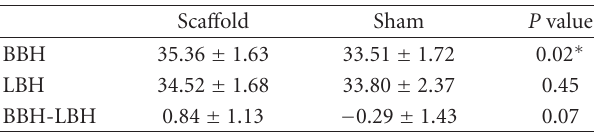
Table 1: Mean values and standard deviations of buccal and lingual bone height (BBH and LBH, respectively) in millimetres after 6 weeks of